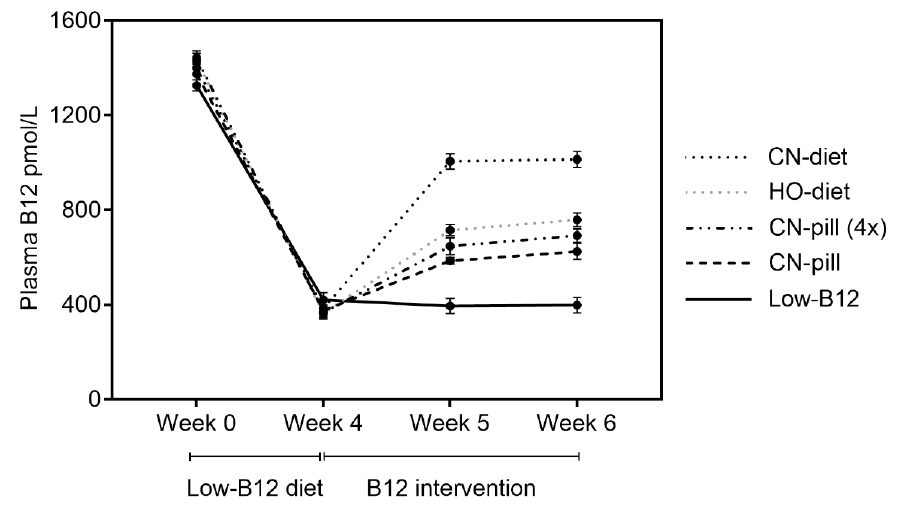
Figure 3. Plasma B12 before and after B12 intervention. Results are shown as means with standard error of mean error of mean (SEM).